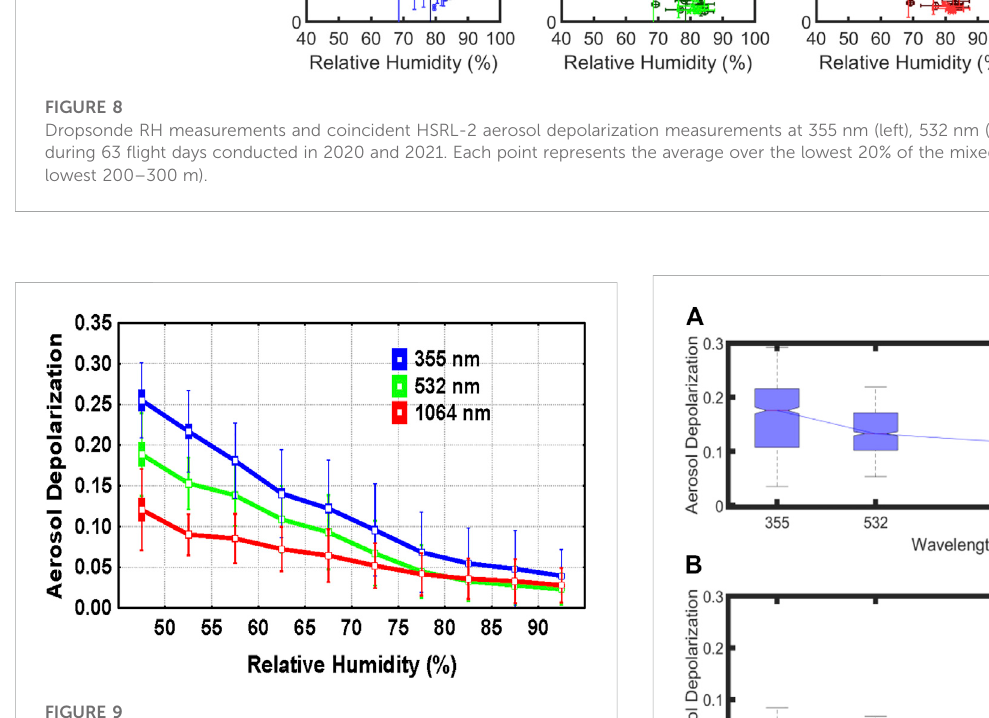
FIGURE 9 Box plot showing aerosol depolarization measured by HSRL-2 as a function of RH averaged over all the HSRL-2/dropsonde coincidences during 2020 and 2021. These results are for altitudes z such that (z/Z i < 0.9) where Z i is the mixed layer height derived from the HSRL-2 data. Open squares show mean values, fi lled boxes show mean ± two standard errors, and whiskers show mean ± one standard deviation.